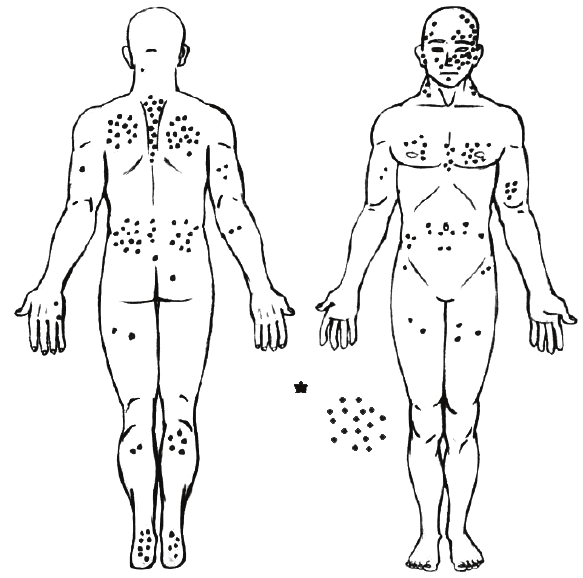
Figure 3: Anatomical sites of cutaneous melanoma lesions in male patients in the western region of Santa Catarina, Brazil, from 2002 to 2009 ( n = 205). ∗ Patients with metastatic cutaneous melanoma for lymph nodes and unknown primary cutaneous site on first presentation.